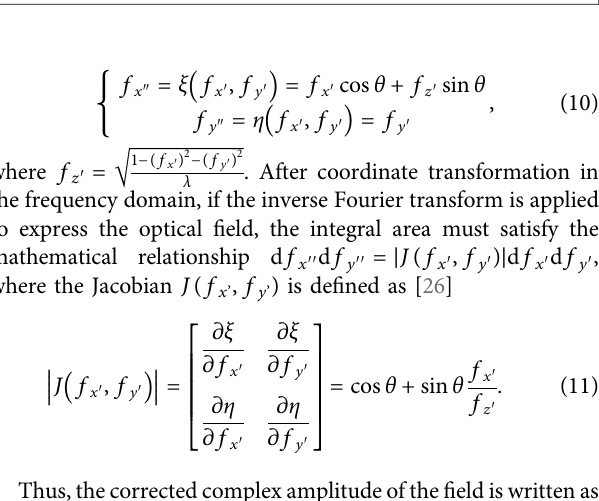
FIGURE3| Experimental setupofRLF-TDH. BS,beamsplitter;PM i ,off- axis parabolic mirror.